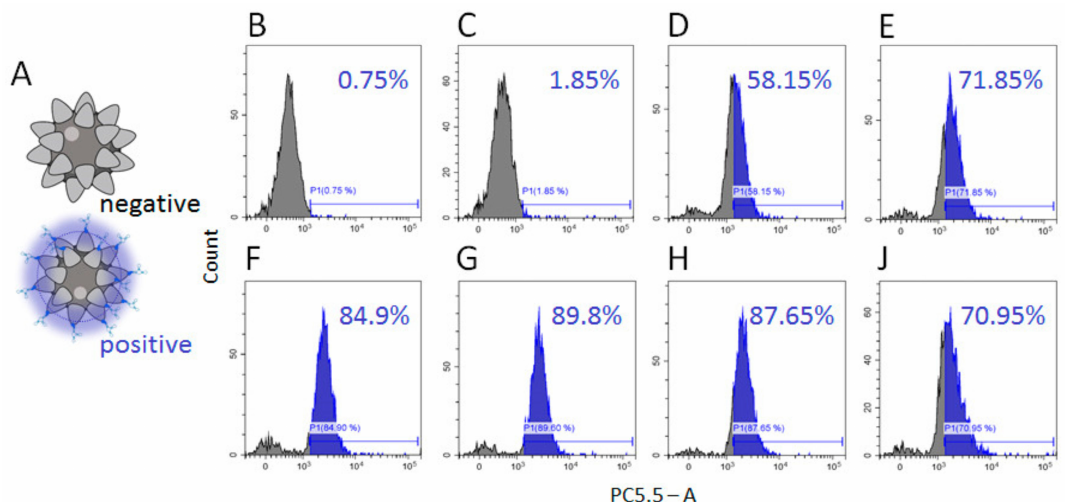
Figure 4. Efficacy of SPMB–PSMA–Apt formation. ( A ) Scheme of experiment: the signal from non-modified SPMBs was set as 0, SPMBs modified with Cy5.5-labeled aptamer were counted as positive events; ( B – G ) efficacy of complex formation with increased amounts of aptamer in a reaction mix (0.01, 0.1, 0.5, 0.7, 1, and 2 pM) for 3 h at room temperature; ( H ) efficacy of complex formation in the presence of DMSO (10%) in reaction mix (1 pM of Apt, 3 h, RT); ( J ) efficacy of complex formation in optimal conditions (1 pM of aptamer, 10% DMSO) overnight at a temperature of 4 ◦